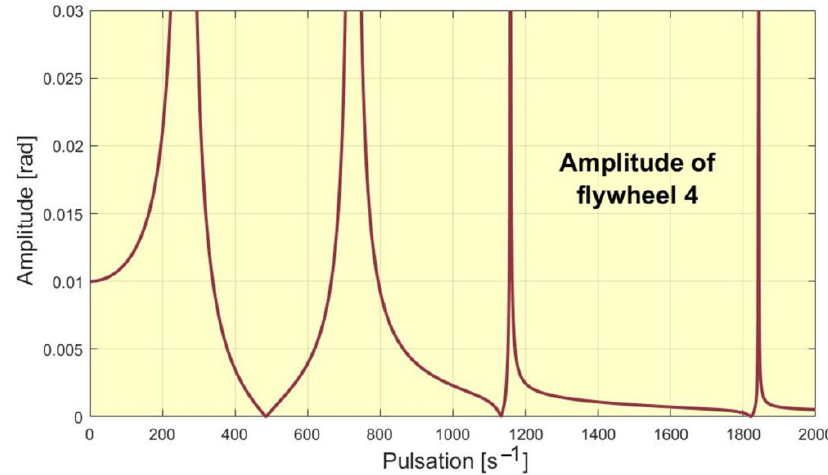
Figure 12. The absorbtion of the flywheel 4 for the simplified system .